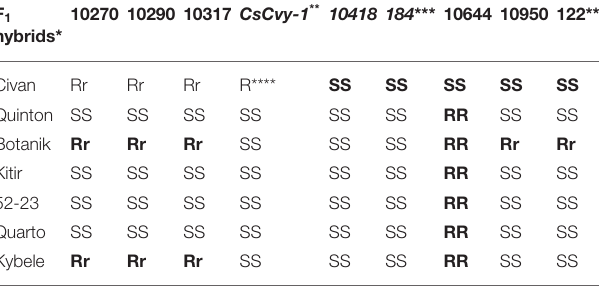
TABLE 3 | Genes within the CsCvy-1 interval in the Chinese Long cucumber